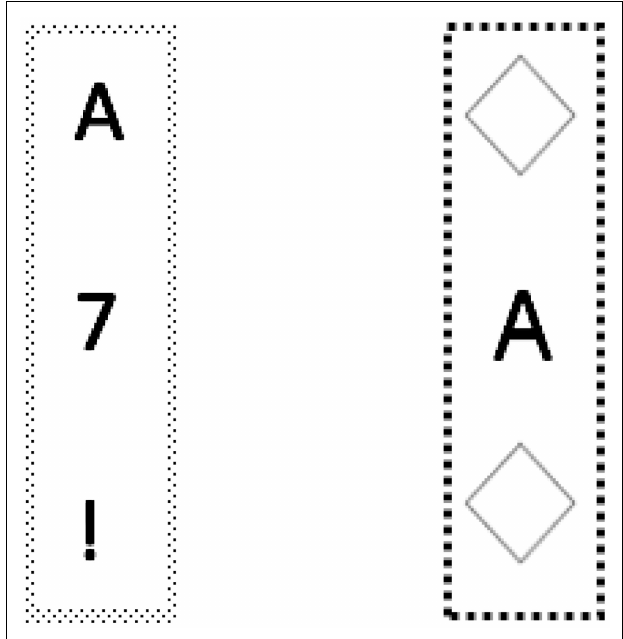
FIGURE 1 | Stimulus display with trivalent stimuli (left) and univalent stimuli (right) in Experiment 1 and 2. Colored frames served as cues. In Experiment 2, the diamonds were replaced by straight